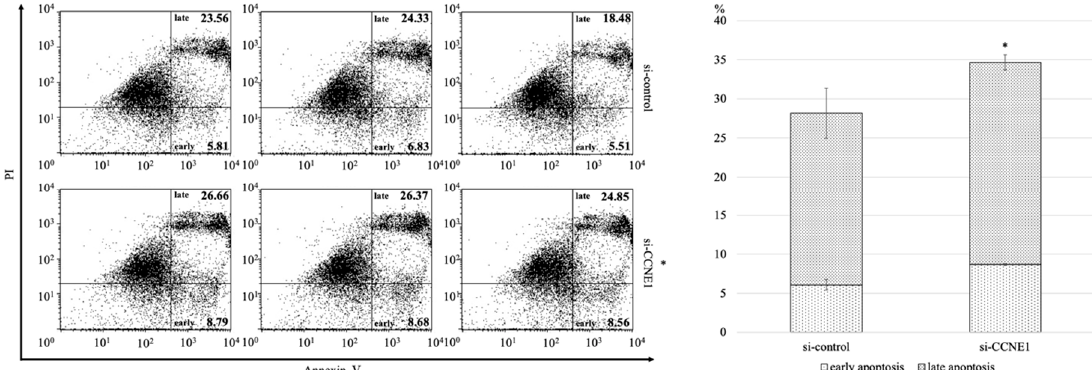
Figure 5. CCNE1 interference on TOV-21G ( ARID1A mutant line) increases apoptotic cells. At 48 h after transfection, early and late apoptosis was found to have increased significantly in the si-CCNE1 group compared to that in the control group (28.2 ± 3.7 vs. 34.6 ± 1.1, p = 0.045). There were three biological replicates per group. * p < 0.05 vs. control.